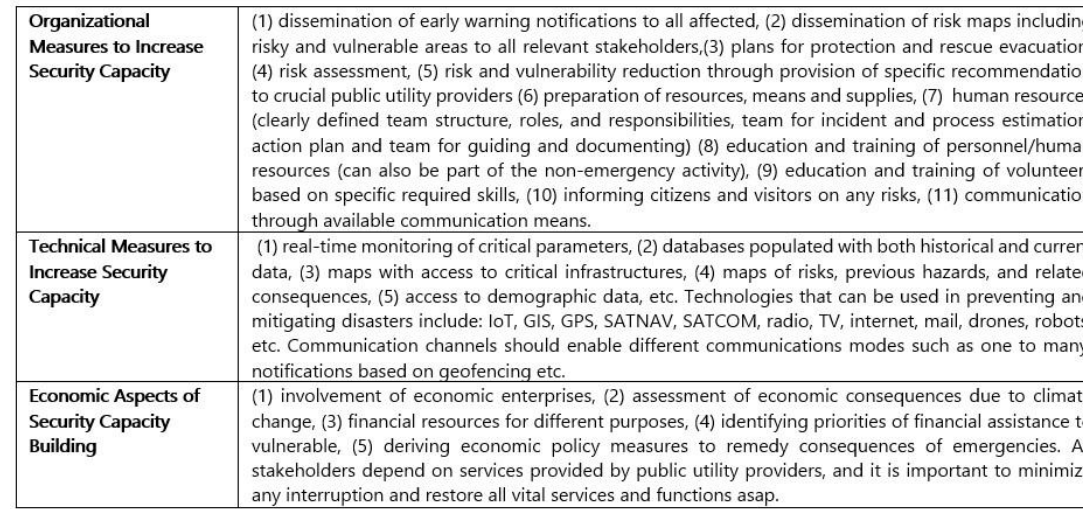
Table 6: Organizational, Technical, and Economic Measures to Increase Security Capacity (Source: Authors’